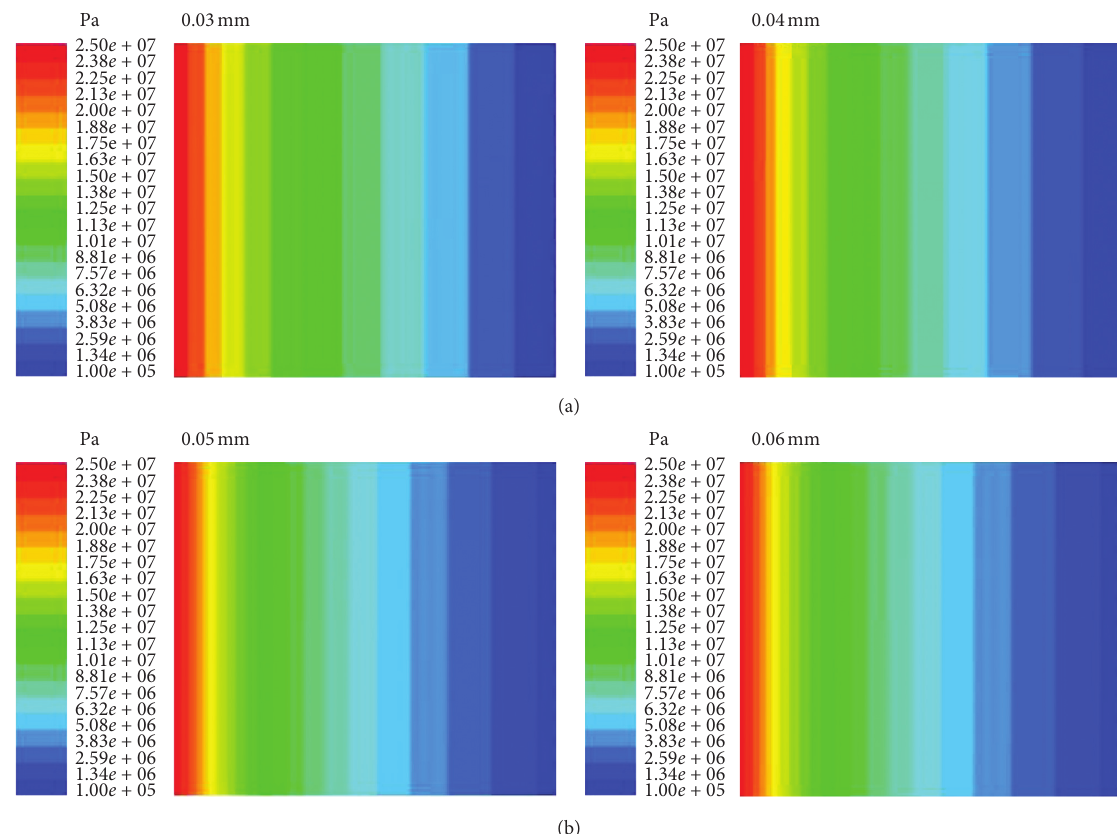
Figure 12: Vectors of pressure at inlet and outlet of end clearance flow field under different